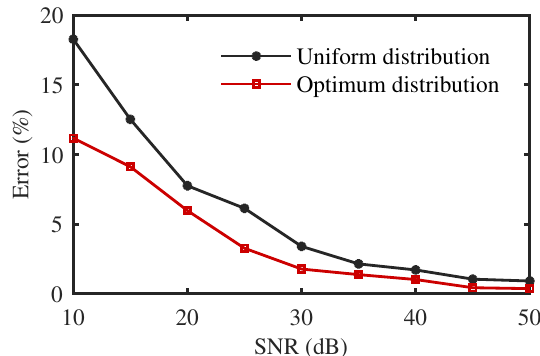
Figure 9. The relative error versus SNR at 2000 Hz.